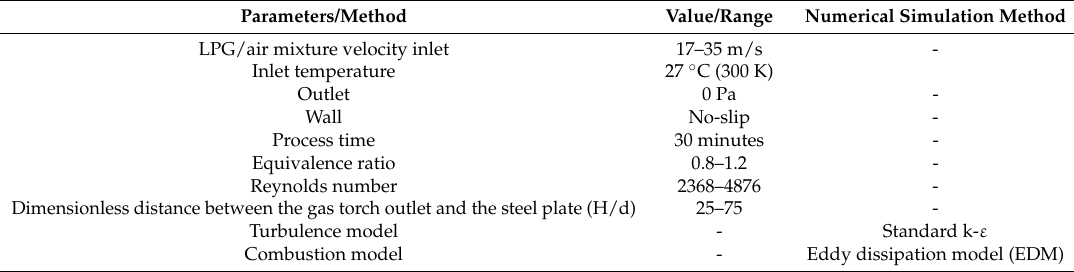
Figure 3. One quarter of the three-dimensional domain: ( a ) From the gas torch exit plane to the impinged steel plate; ( b ) mesh model. Table 1. Boundary conditions and numerical simulation